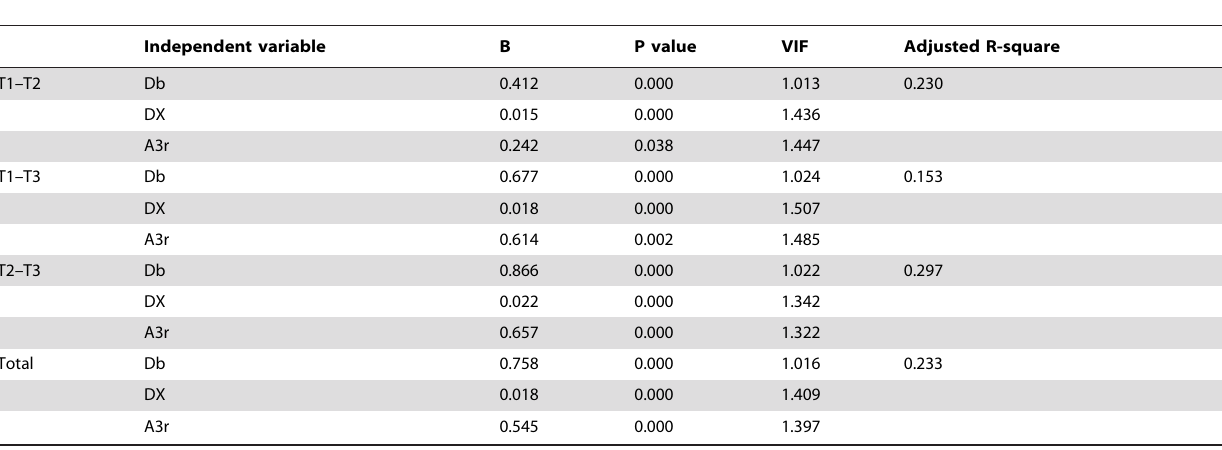
Table 4. Variables included in multiple regression